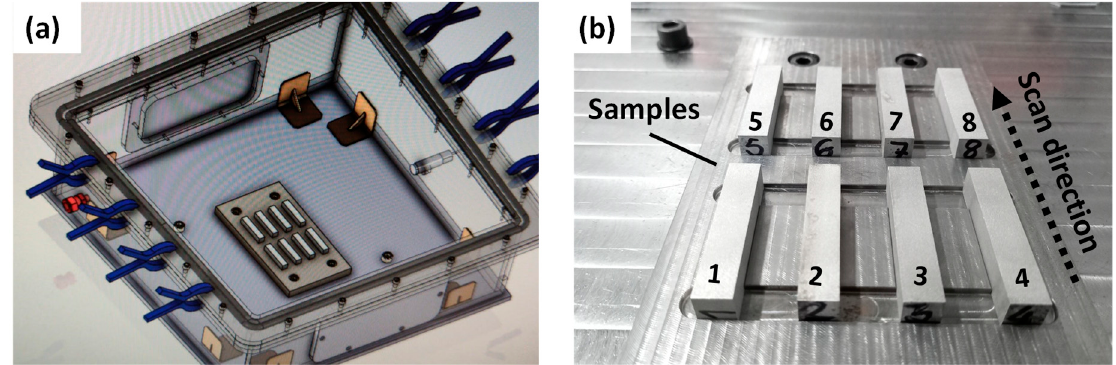
Figure 6. ( a ) Experimental set-up of the methodology and ( b ) sample location inside the inert chamber.